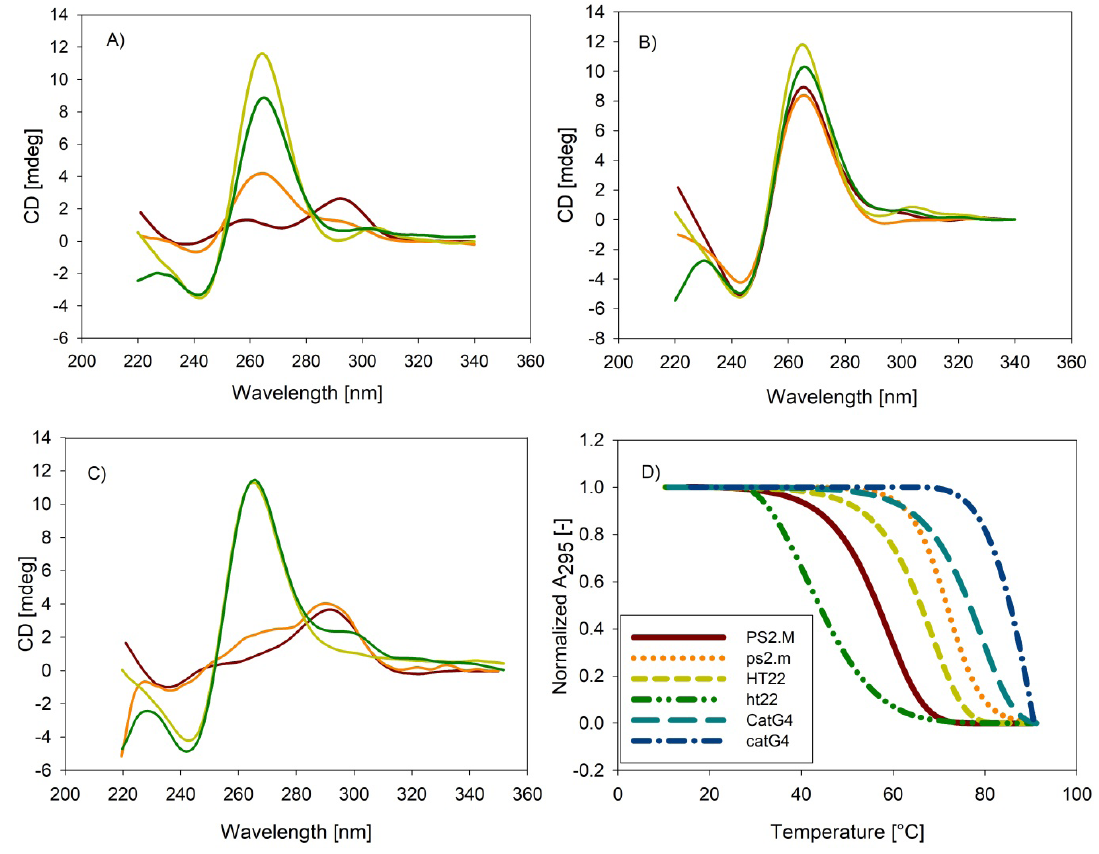
Figure 2: Spectral characterization of G-quadruplex formed by studied sequences. CD spectra of ps2.m (A), catg4 (B), ht22 (C), where brown line corresponds to DNA oligonucleotide, orange line – DNA oligonucleotide + hemin, yellow line – RNA oligonucleotide, green line – RNA oligonucleotide + hemin. Panel D shows melting profiles of DNA and 2’OMeRNA sequences obtained using UV-Vis spectrophotometry.